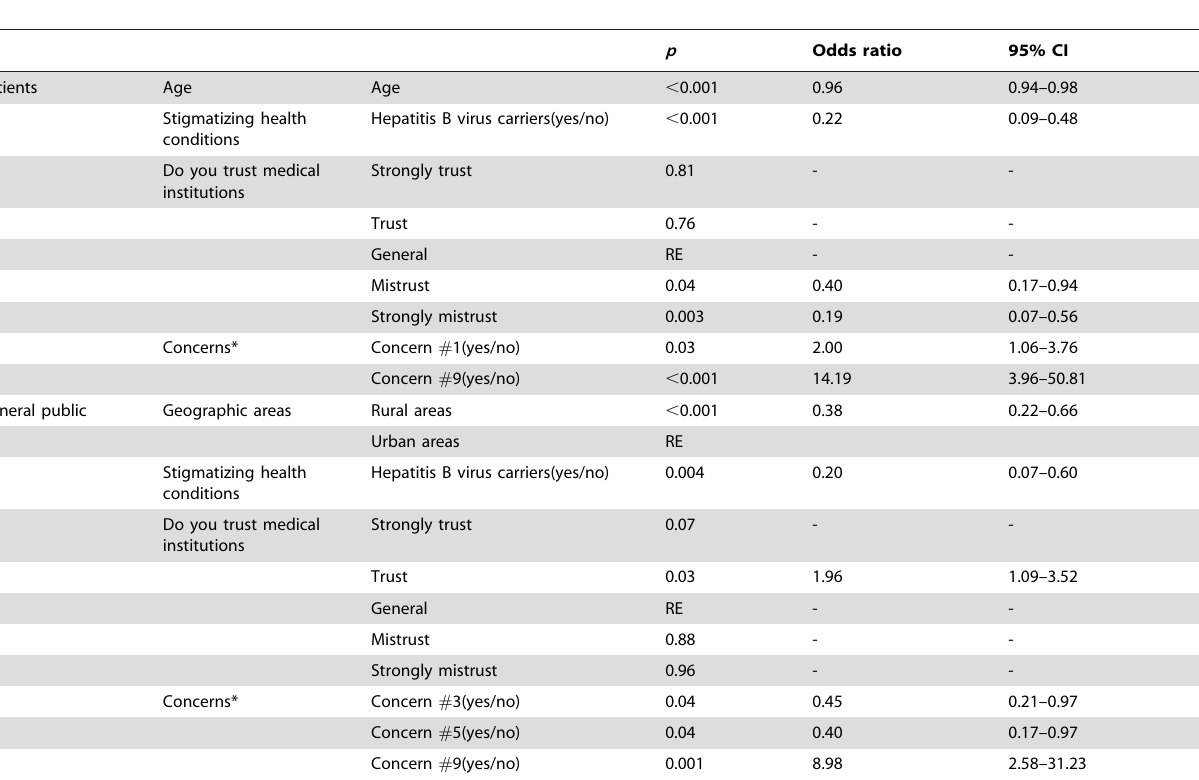
Table 1. Results of multiple logistic regressions examining demographic and attitudinal differences in preferences to donate